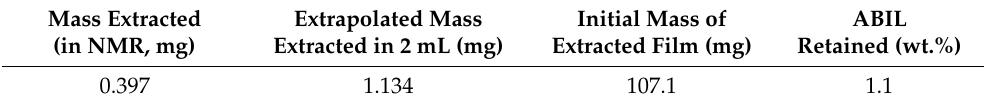
Table 7. [TMG][OAc] quantification in the cellulose pulp cellulose(H)-PNIPAAm film. Mass Extracted Extrapolated (in NMR, mg)